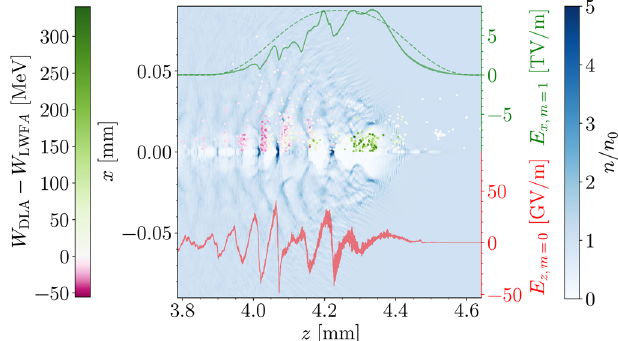
FIG. 5. Snapshot of the electron density profile after 4.64 mm of propagation (left to right) through the plasma; z and x are the longitudinal and transverse directions, respectively. Also shown are the m ¼ 0 longitudinal electric field (SM-LWFA) overlaid in red and the m ¼ 1 transverse electric field envelope (DLA) in green. The dashed green line shows the vacuum laser field envelope at the focus. The tracked electrons, with x positions given by their radial distance (only half-space is shown), indicate where in space each acceleration mechanism is dominant. The charge density has been integrated in θ